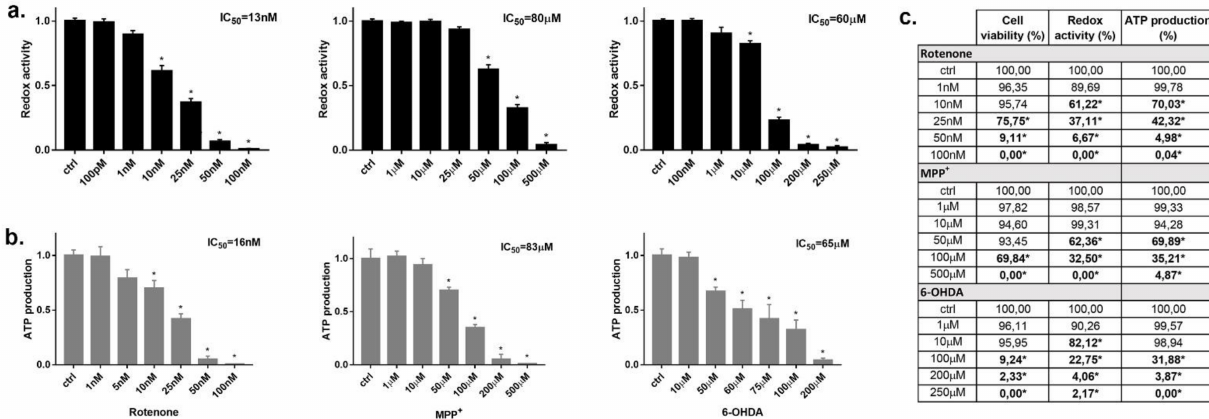
Figure 3. Effect of rotenone, MPP + and 6-OHDA on INS-1 β -cells mitochondrial function. Changes of mitochondrial redox activity ( a ) and ATP production ( b ) in INS-1 cells treated for 24 h to increasing concentrations with the three toxins. ( a ) Redox activity was evaluated as difference in absorbance values for cells treated with the toxins compared to control after incubation with alamarBlue Reagent. ( b ) Cellular ATP content was evaluated as difference in luminescence values for cells treated with the toxins compared to control by using ATPlite assay. Data are expressed as mean ± SEM of four independent experiments and normalized over control signal. * p < 0.05 compared to control, ANOVA, Dunnett’s post hoc test. ( c ) % of reduction in the presence of the three toxins in the different assays (cell viability, redox activity and ATP production) are confronted in terms of cell death and mitochondrial inhibition. * bold p < 0.05 compared to control, ANOVA, Dunnett’s post hoc